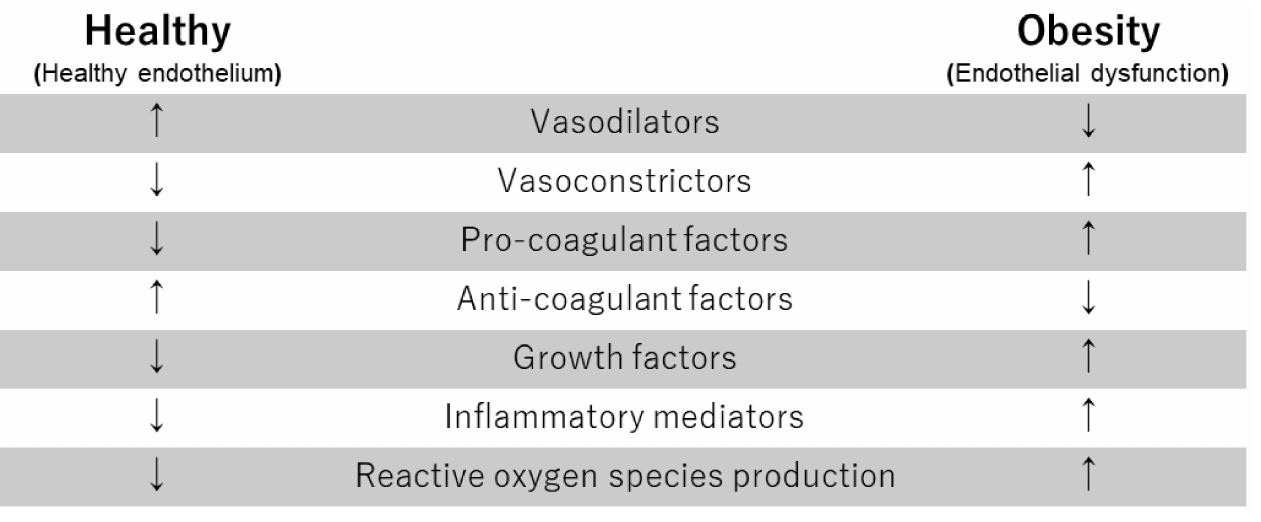
Figure 1. The function of endothelial cells in healthy subjects and obese